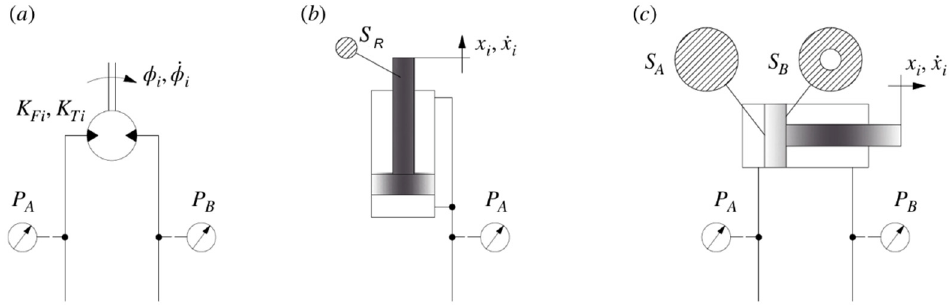
Figure 4. Tilt rotary actuator ( a ), lift single-acting cylinder ( b ), extension double-acting cylinder ( c ).